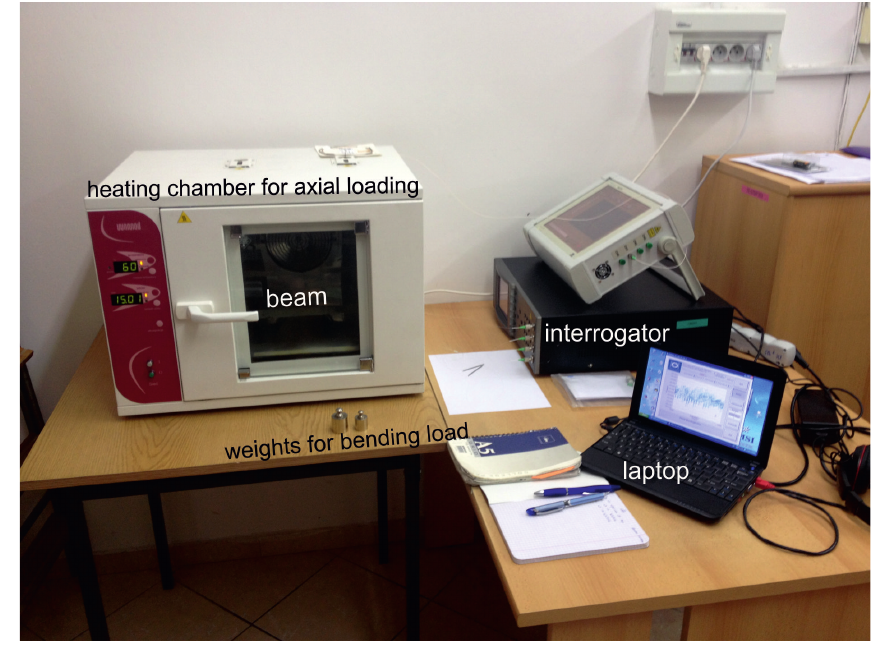
Figure 4. Experimental